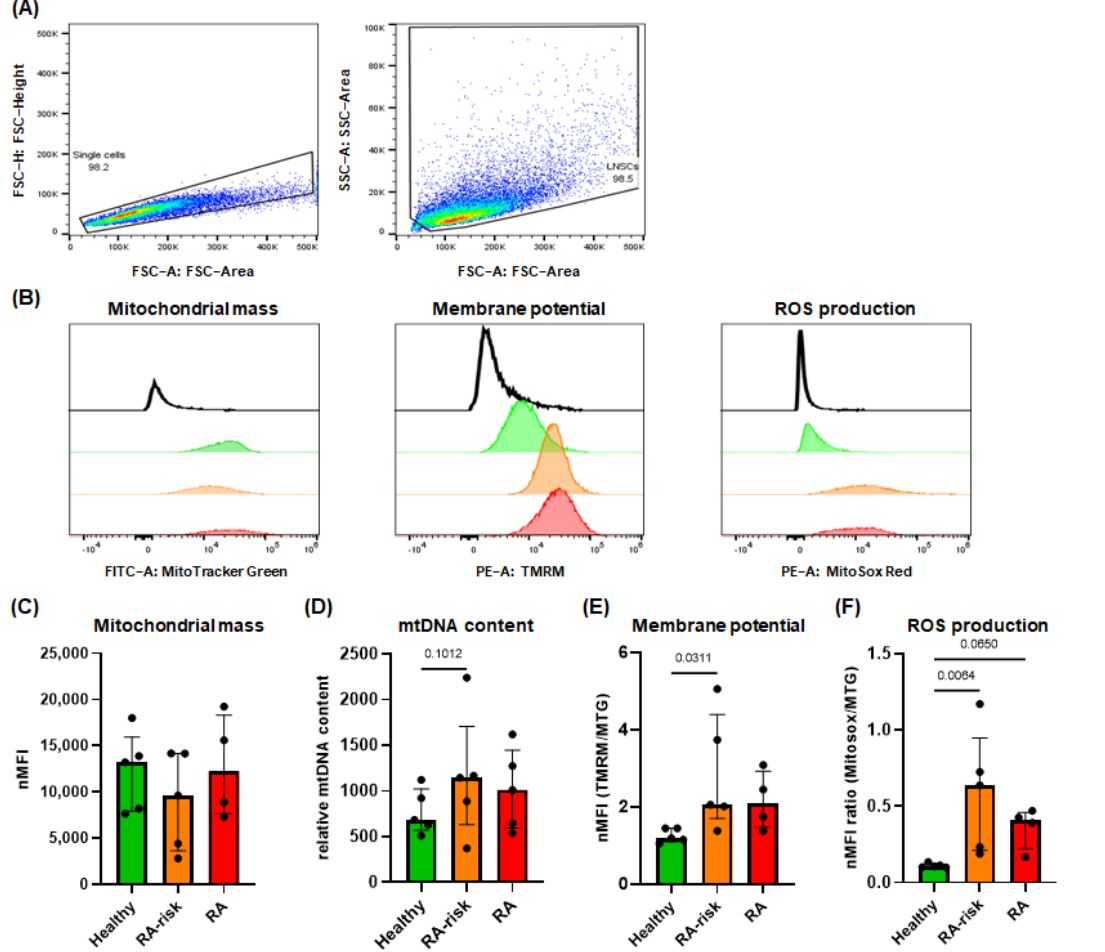
Figure 3. Higher mitochondrial membrane potential and ROS production in RA-risk LNSCs compared with healthy LNSCs. ( A ) Flow cytometry gating strategy used to identify LNSCs and single cells. Numbers adjacent to the outlined areas indicate percentages of cells in the gated population. ( B ) Representative histograms of the mitochondrial mass, membrane potential and ROS production of cultured LNSCs. Unstained healthy LNSCs (black), healthy (green), RA-risk individuals (orange) and RA patients (red). MFI quantification was normalized per donor for unstained cells because of inter-individual variation. ( C ) Mitochondrial mass measured using MitoTracker Green. ( D ) Relative mtDNA content normalized against nuclear DNA. ( E ) Mitochondrial membrane potential measured using tetramethylrhodamine, methyl ester (TMRM). ( F ) Mitochondrial ROS production measured using MitoSox Red. All flow cytometry measurements are normalized for unstained cells. Membrane potential and ROS production were additionally normalized for mitochondrial mass. All donors passage 5, unstimulated conditions. N = 5 per group for healthy and RA-risk, N = 4 for RA LNSCs, 2 technical replicates for mtDNA content measurements. Data are presented as median + interquartile range. Statistical differences were determined using Kruskal- Wallis + Dunn’s multiple comparisons test.